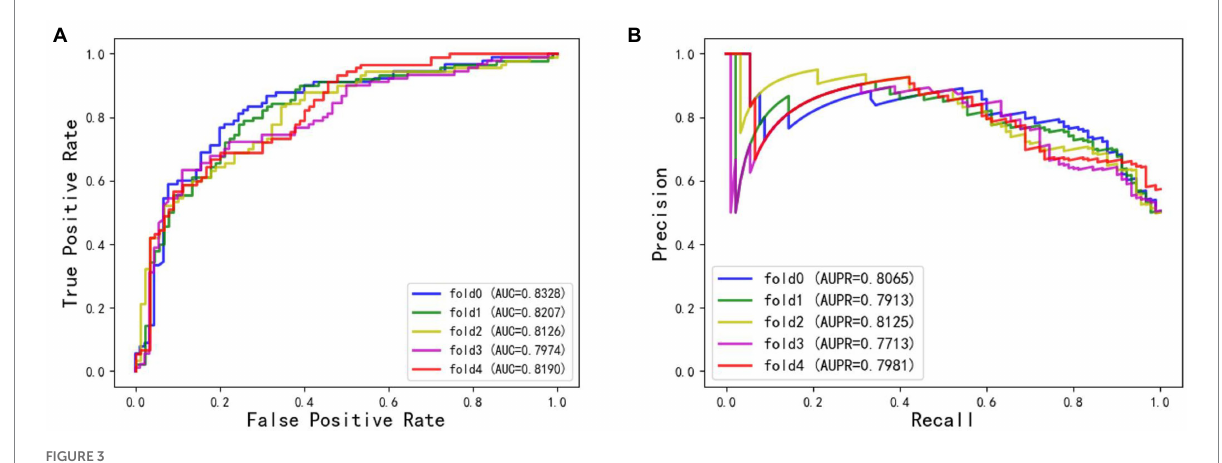
FIGURE 3 (A) The ROC curves of Iter5. (B) The AUPR curves of